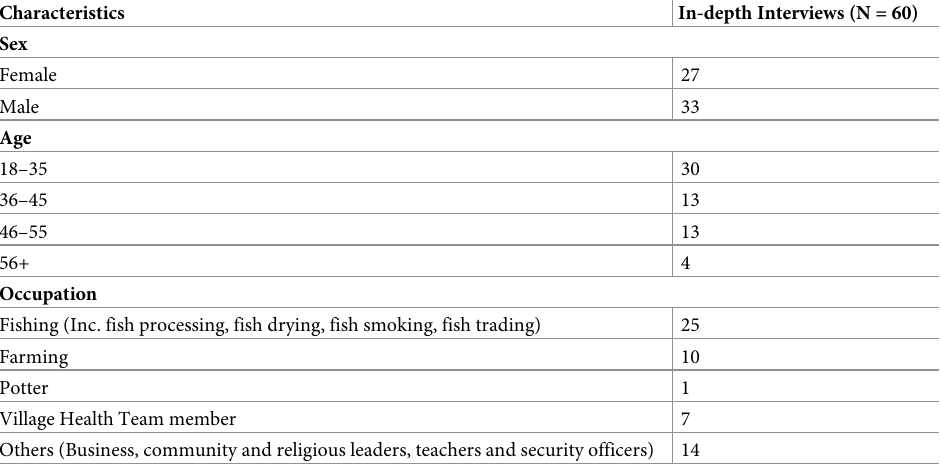
Table 1. Social demographic characteristics of study participants for the in-depth